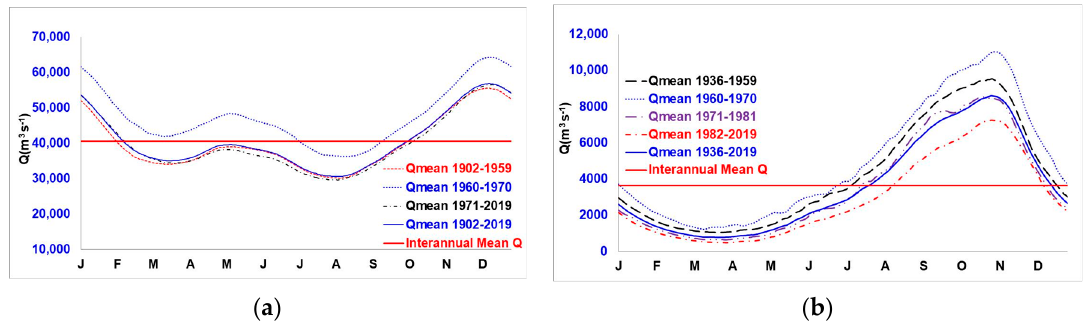
Figure 11. ( a ) Changes in mean daily hydrological regimes by homogeneous flow periods for Congo River at BZV/KIN, ( b ) and Ubangi at Bangui. The total periods of available daily Q are presented for each station.